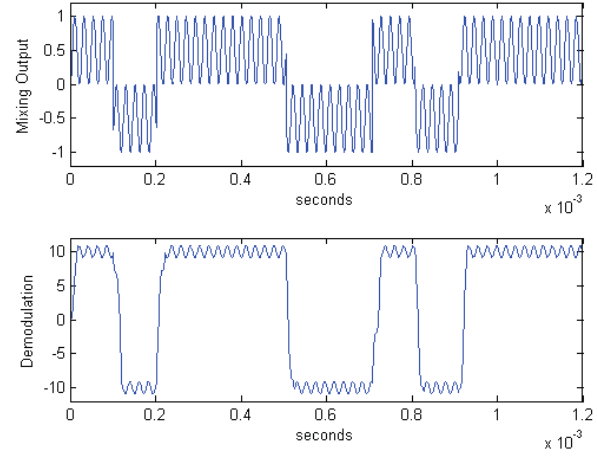
Figure 18. Simulation result of low-pass filter.